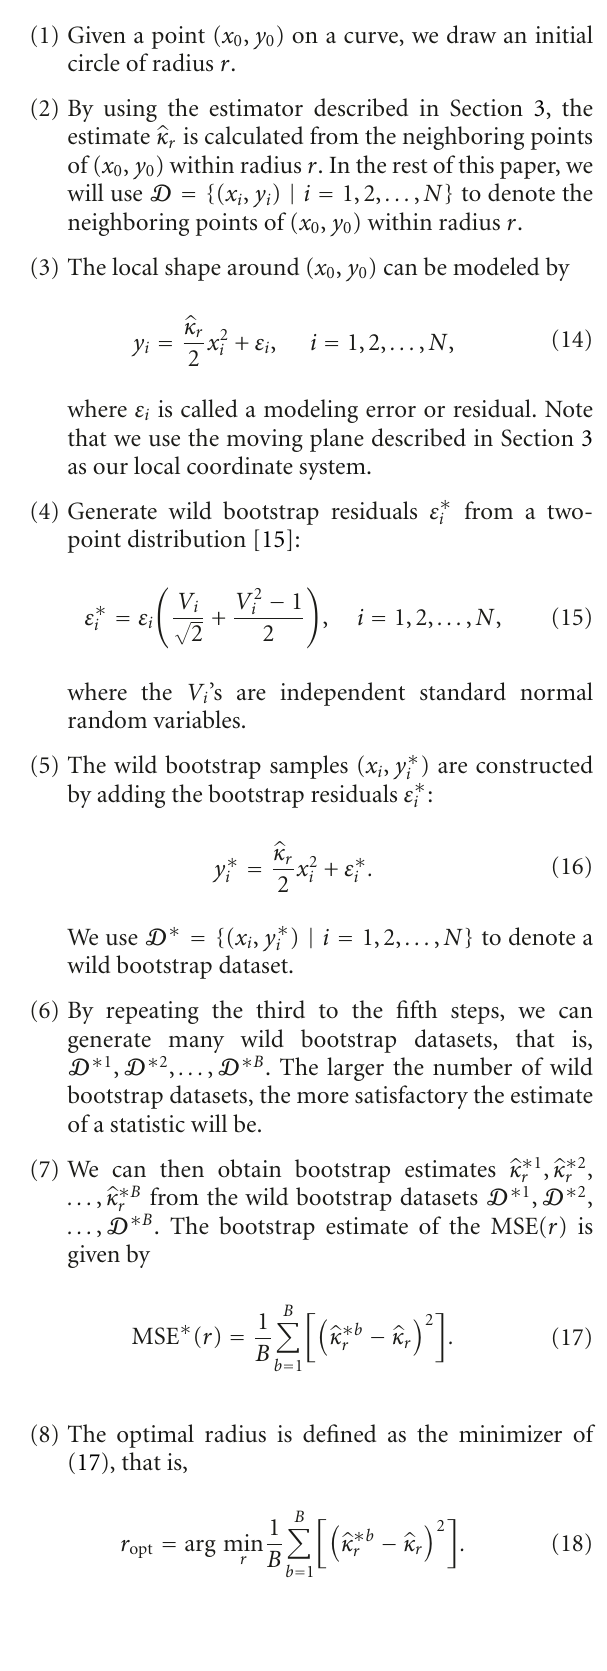
The conceptual block diagram of the radius selection algorithm using bootstrap method is shown in Figure 2 and the detailed steps are described